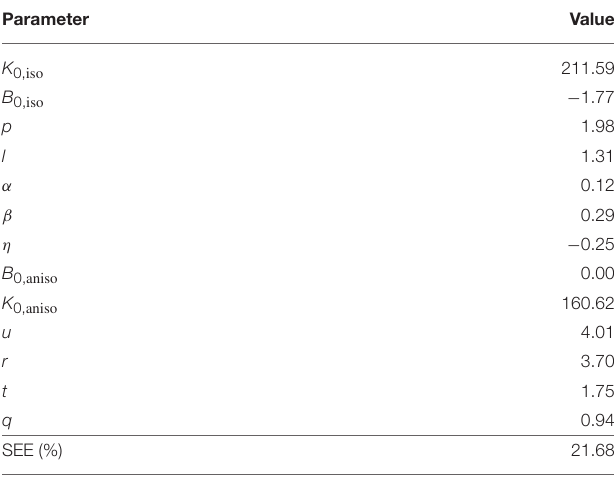
TABLE 5 | Value of the parameters and SEE of the combined isotropic/anisotropic model with tension/compression asymmetry. Parameter Value K 0,